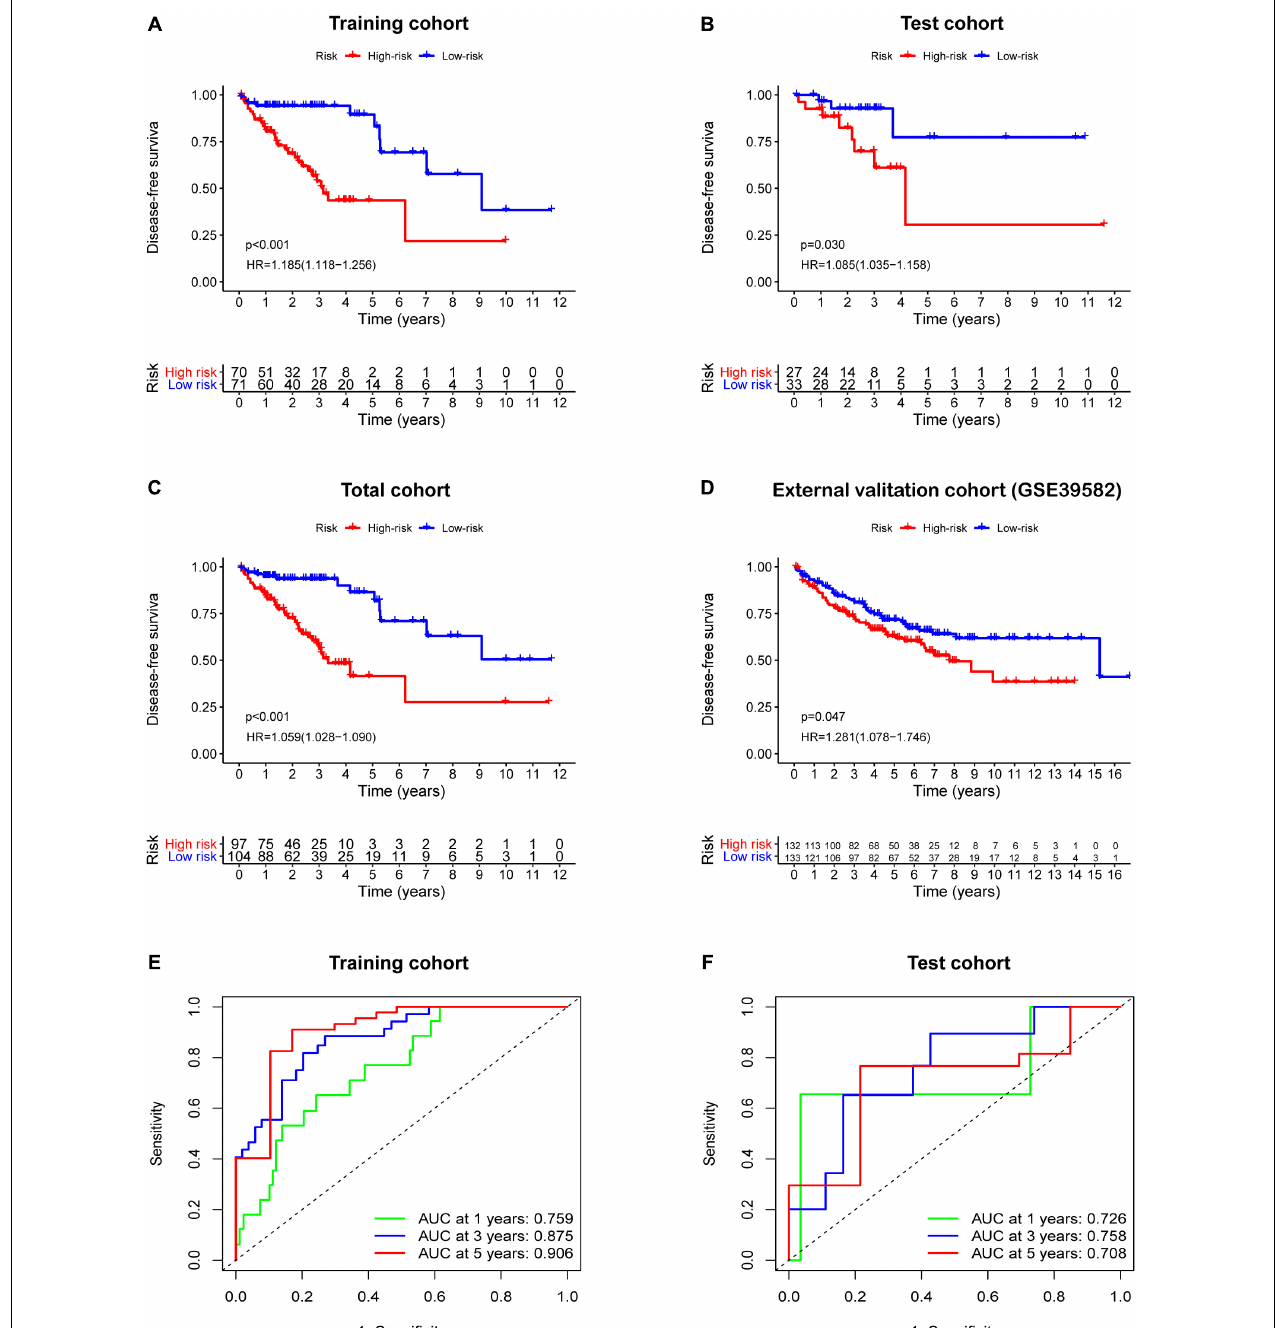
FIGURE 3 | Survival analysis based the IRGCRCII risk score in four cohorts. Kaplan-Meier curves of DFS for patients in the high and low-risk subgroups of the training cohort (A) , test cohort (B) , total cohort (C) , and external validation cohort (D) . Time-dependent ROC curves analysis at 1, 3, 5-years DFS of the train cohort (E) and the test cohort (F) . p < 0.05. DFS, disease-free survival; HR, hazard ratio; ROC, receiver operating characteristic.